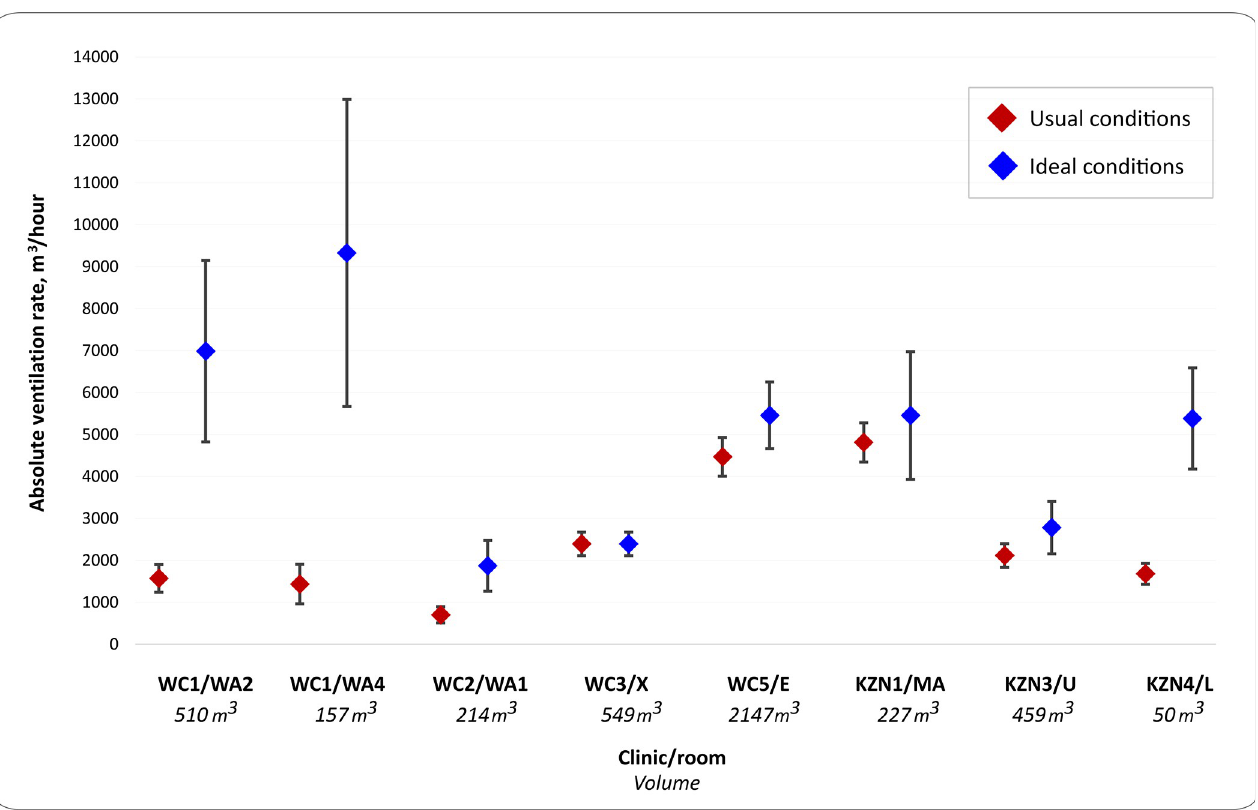
Fig 6. Absolute ventilation rates of eight clinic waiting rooms under usual and ideal conditions, estimated by the rebreathed fraction approach. Usual conditions = configuration of windows and doors observed when the room was in routine use. Ideal conditions = all windows and doors maximally open. Clinic WC3, room X: Usual conditions the same as ideal conditions. Vertical bars indicate upper and lower estimates of 95% confidence intervals WC: Western Cape; KZN: KwaZulu-Natal; WA2, WA4, WA1, X, E, MA, U, L are the codes for the specific waiting rooms where experiments were performed.